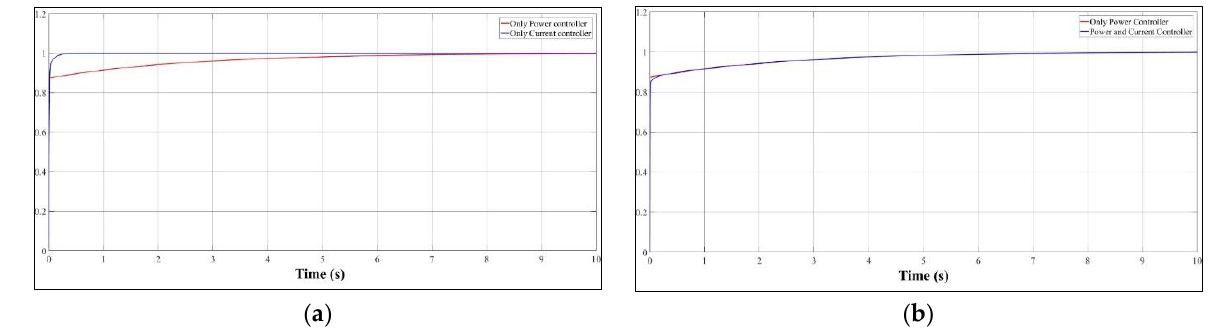
Figure 6. Dynamic response curves of the power controller and current regulator.